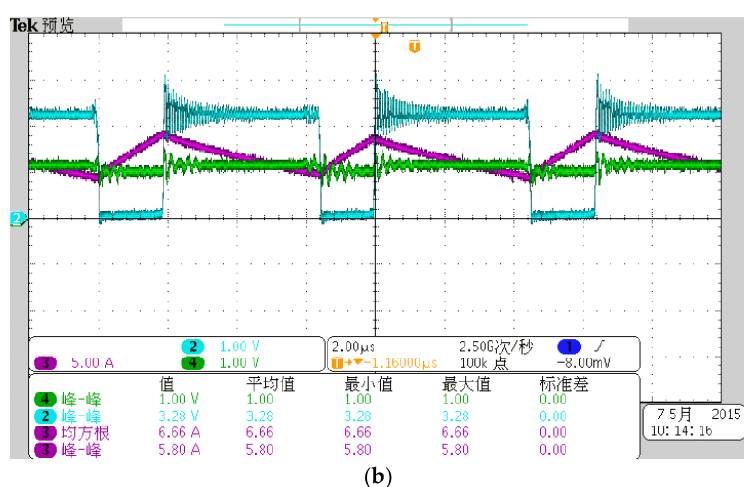
Figure 16. Purple curve: the input current of q ‐ Zsource, green curve shows the input voltage of q ‐ Zsource, cyan curve shows the output voltage of q ‐ Zsource measured ( a ) at the 1 μ s shoot ‐ through time; and ( b ) at the 1.5 μ s shoot ‐ through time.